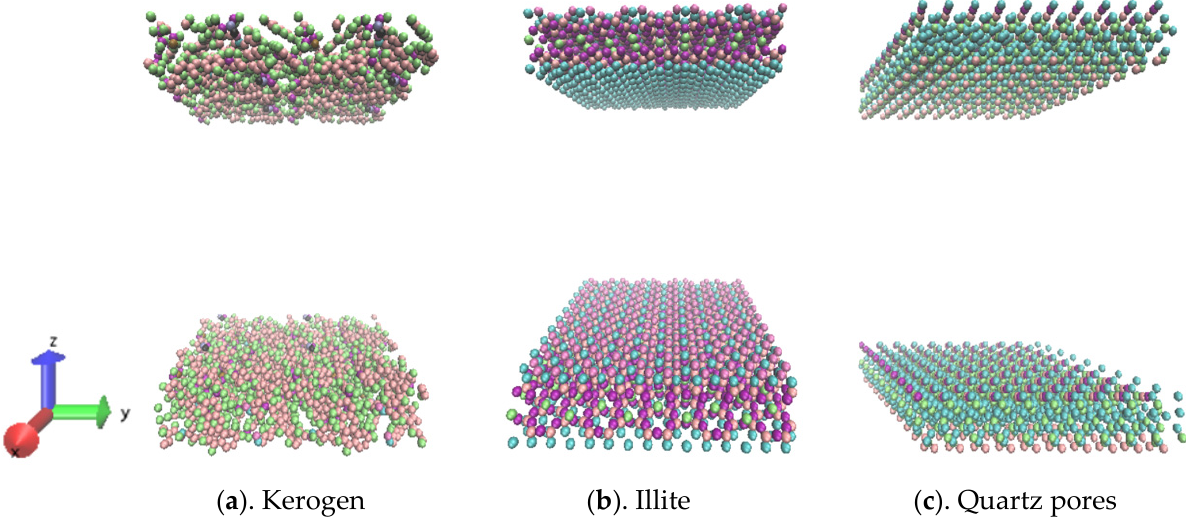
Figure 5. Schematic diagram of pore structures of different shale matrix.